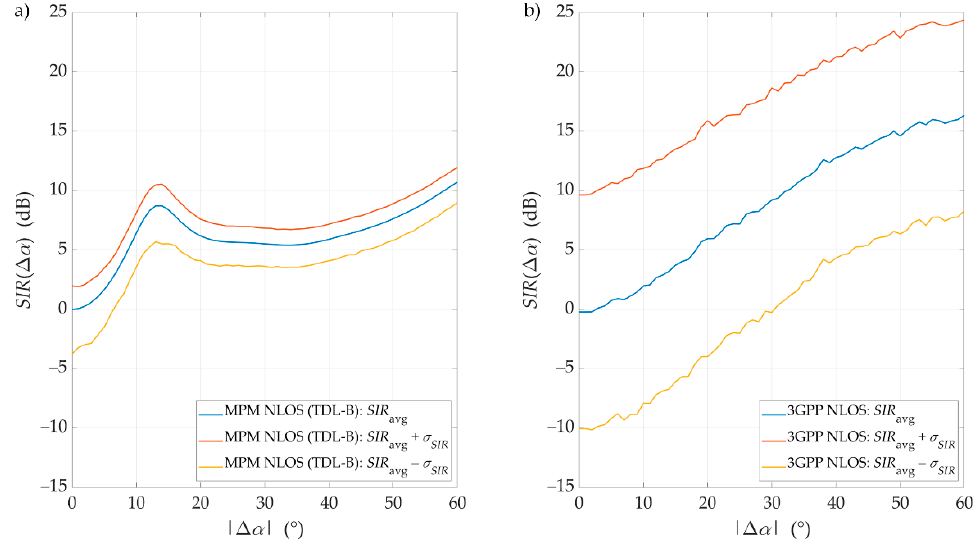
Figure 12. Exemplary SIRs with confidence intervals versus angle of beam separation for NLOS conditions, D = 100 m, obtained for ( a ) the MPM and ( b ) the 3GPP model.